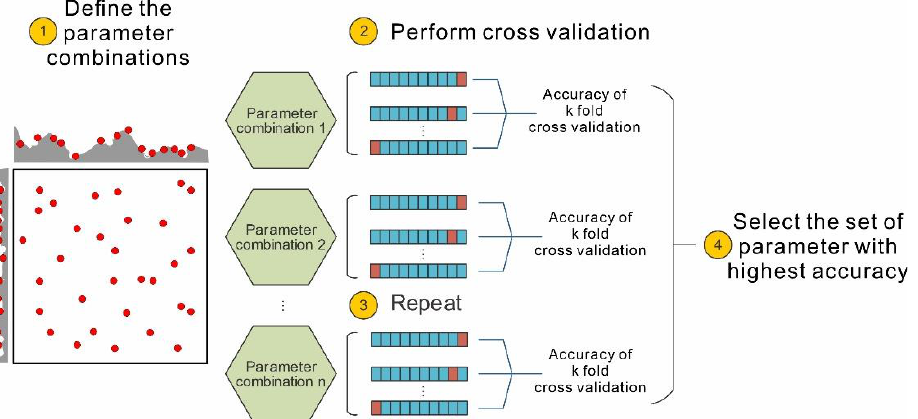
Figure 5. Schematic diagram showing hyperparameter tuning based on the k-fold CV and random grid search methods.